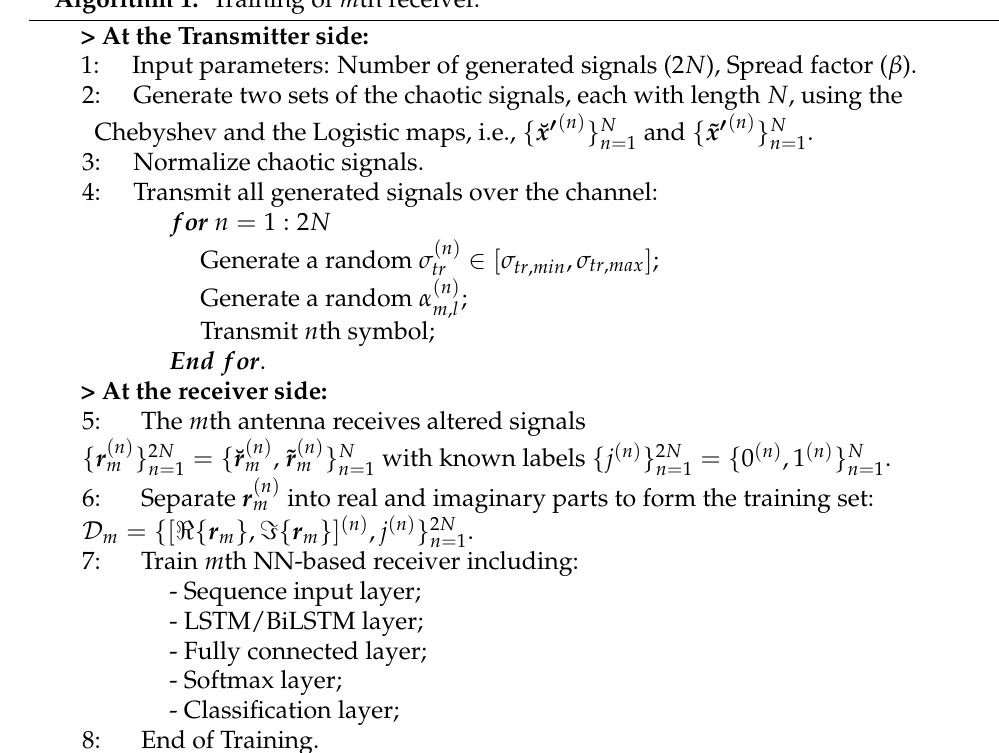
Algorithm 1: Training of m th